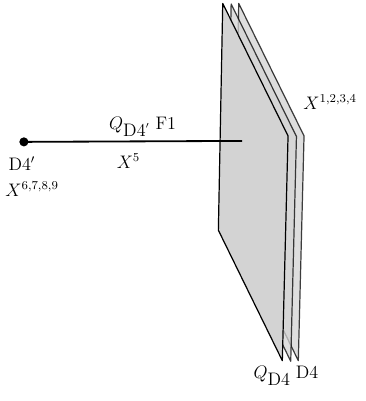
Figure 3 . Young tableau labelling the irreducible representations of U ( N ) .